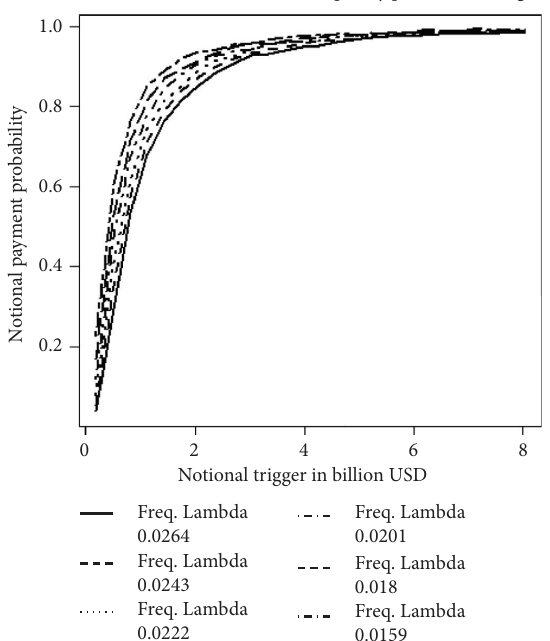
Figure 30: Cyber bond probability of loss for 3 years for λ in the interval λ ± λ ·